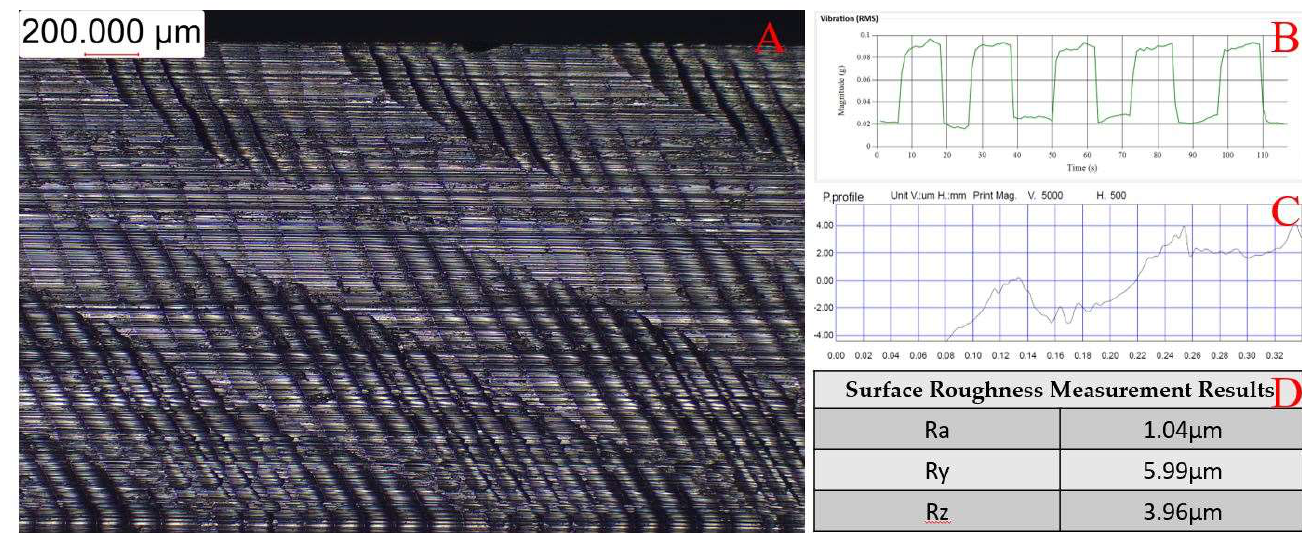
Figure 24. D8 measurement result of Parameter 3.